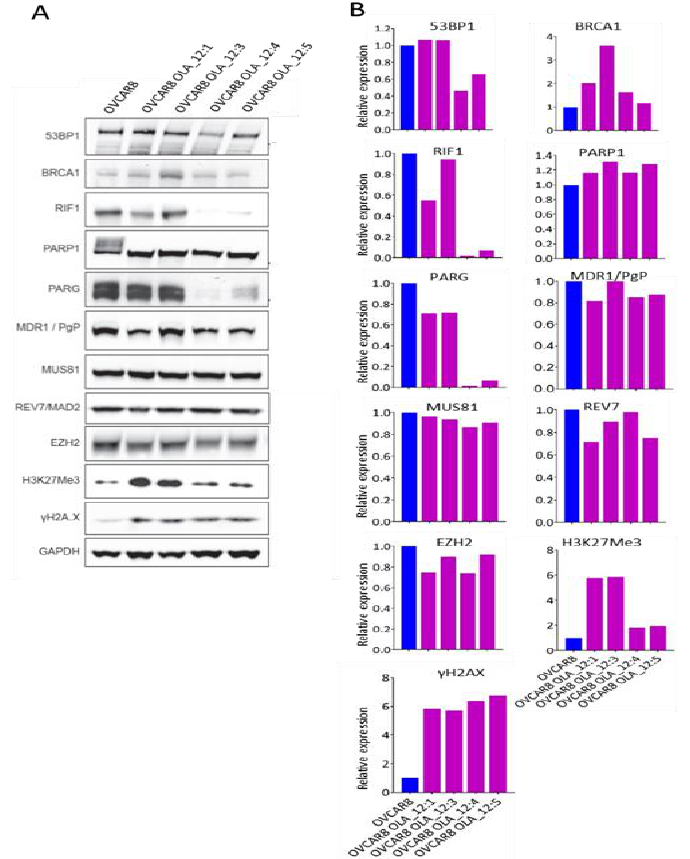
Figure 4. Changes in protein levels in OVCAR8-derived olaparib-resistant clones. Protein lysates were made from the OVCAR8 parent grown in normal medium and OVCAR8 clones maintained continuously under olaparib selection. ( A ) Western blots for 53BP1, BRCA1, RIF1, PARP1, PARG, MDR1, MUS81, REV7, EZH2, H3K27Me3, γH2AX from OVCAR8 and four olaparib-resistant OVCAR8 derived clones, with GAPDH as loading control. ( B ) Histograms showing levels of the different proteins in each clone, corrected for differences in loading control, and expressed relative to